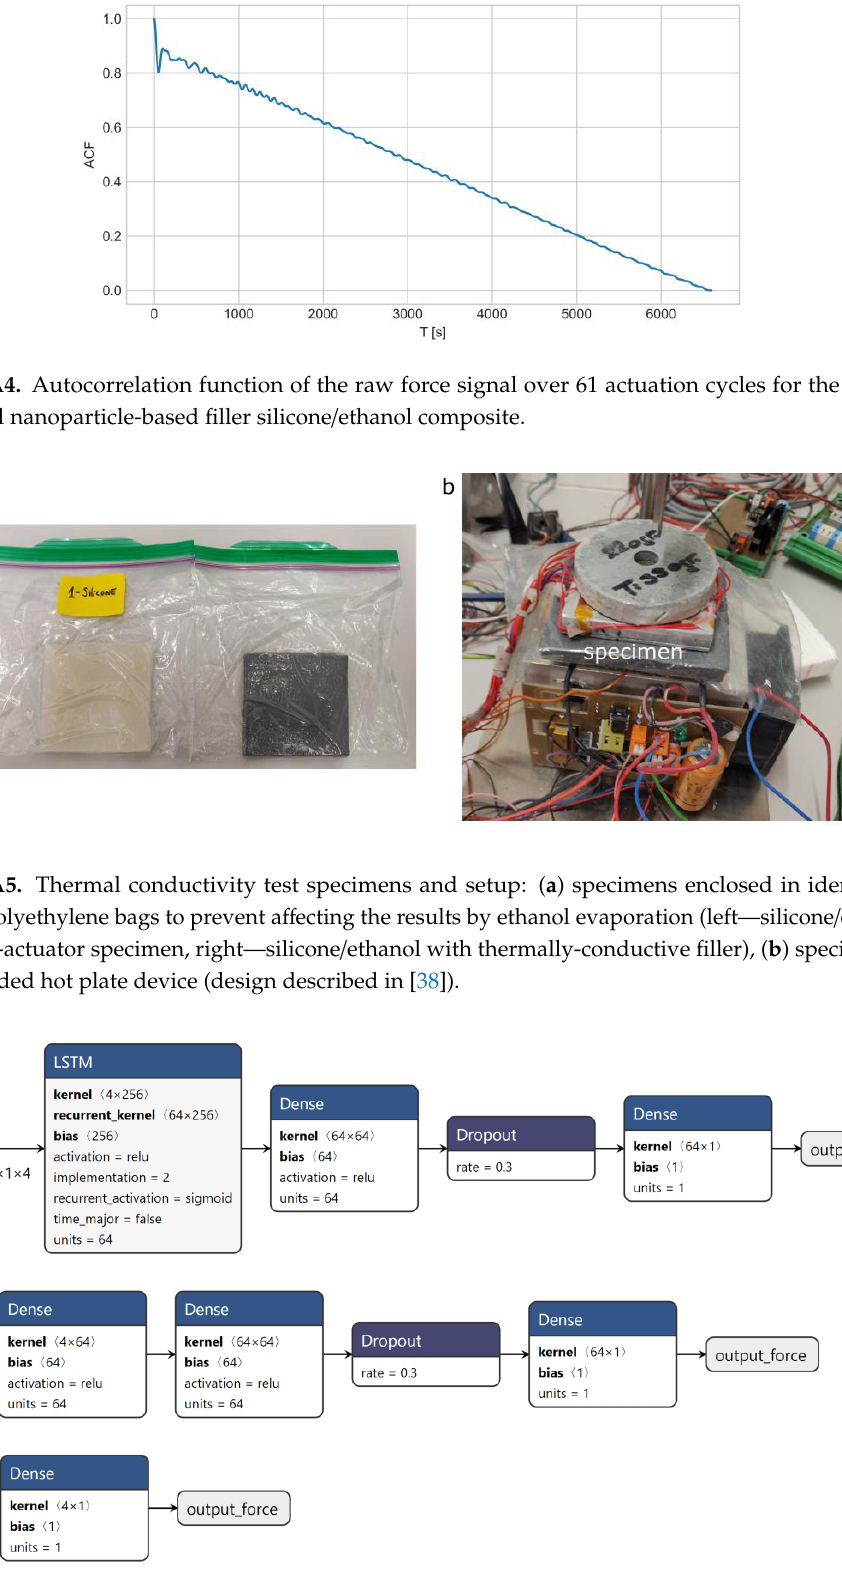
Figure A6. Models for predicting the force output. ( a ) LSTM model ( b ) baseline model, ( c ) linear regression (visualized using Netron: https://github.com/lutzroeder/netron).